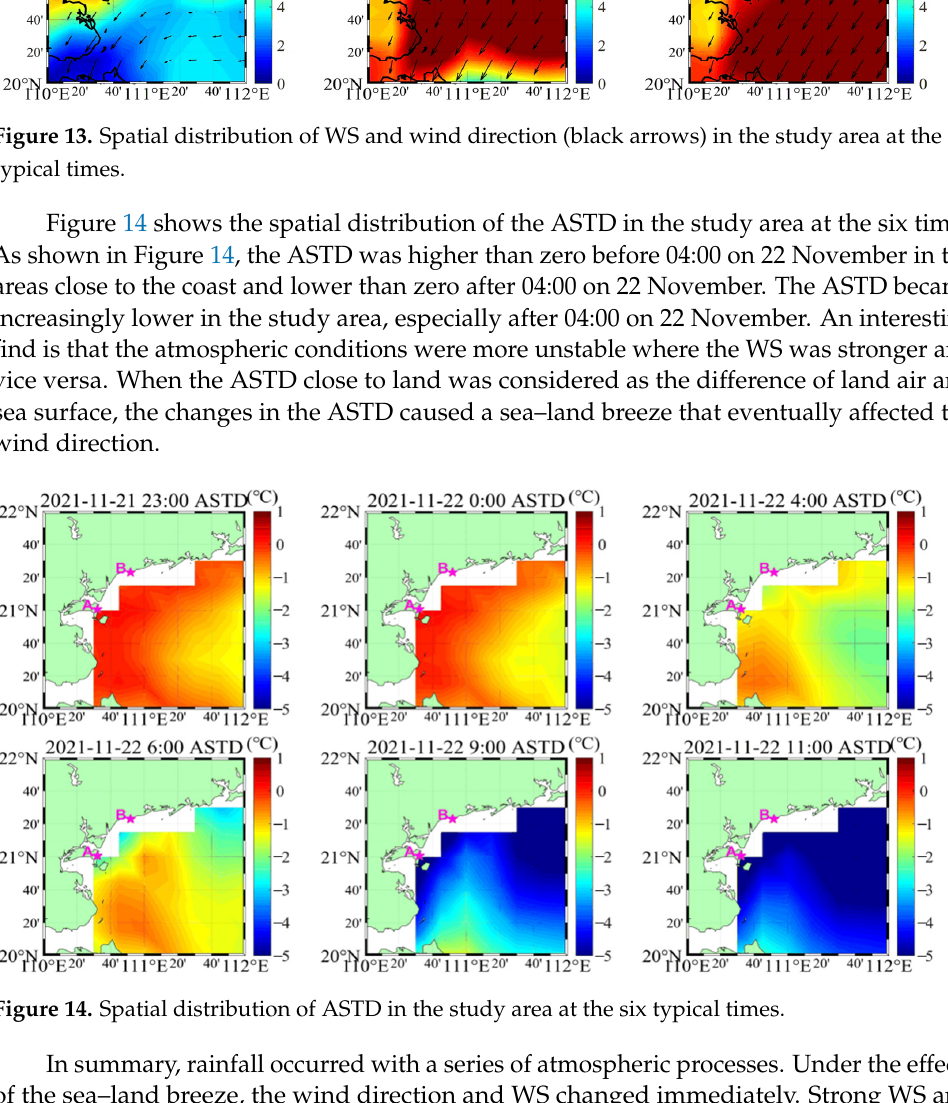
Figure 13. Spatial distribution of WS and wind direction (black arrows) in the study area at the six typical times.